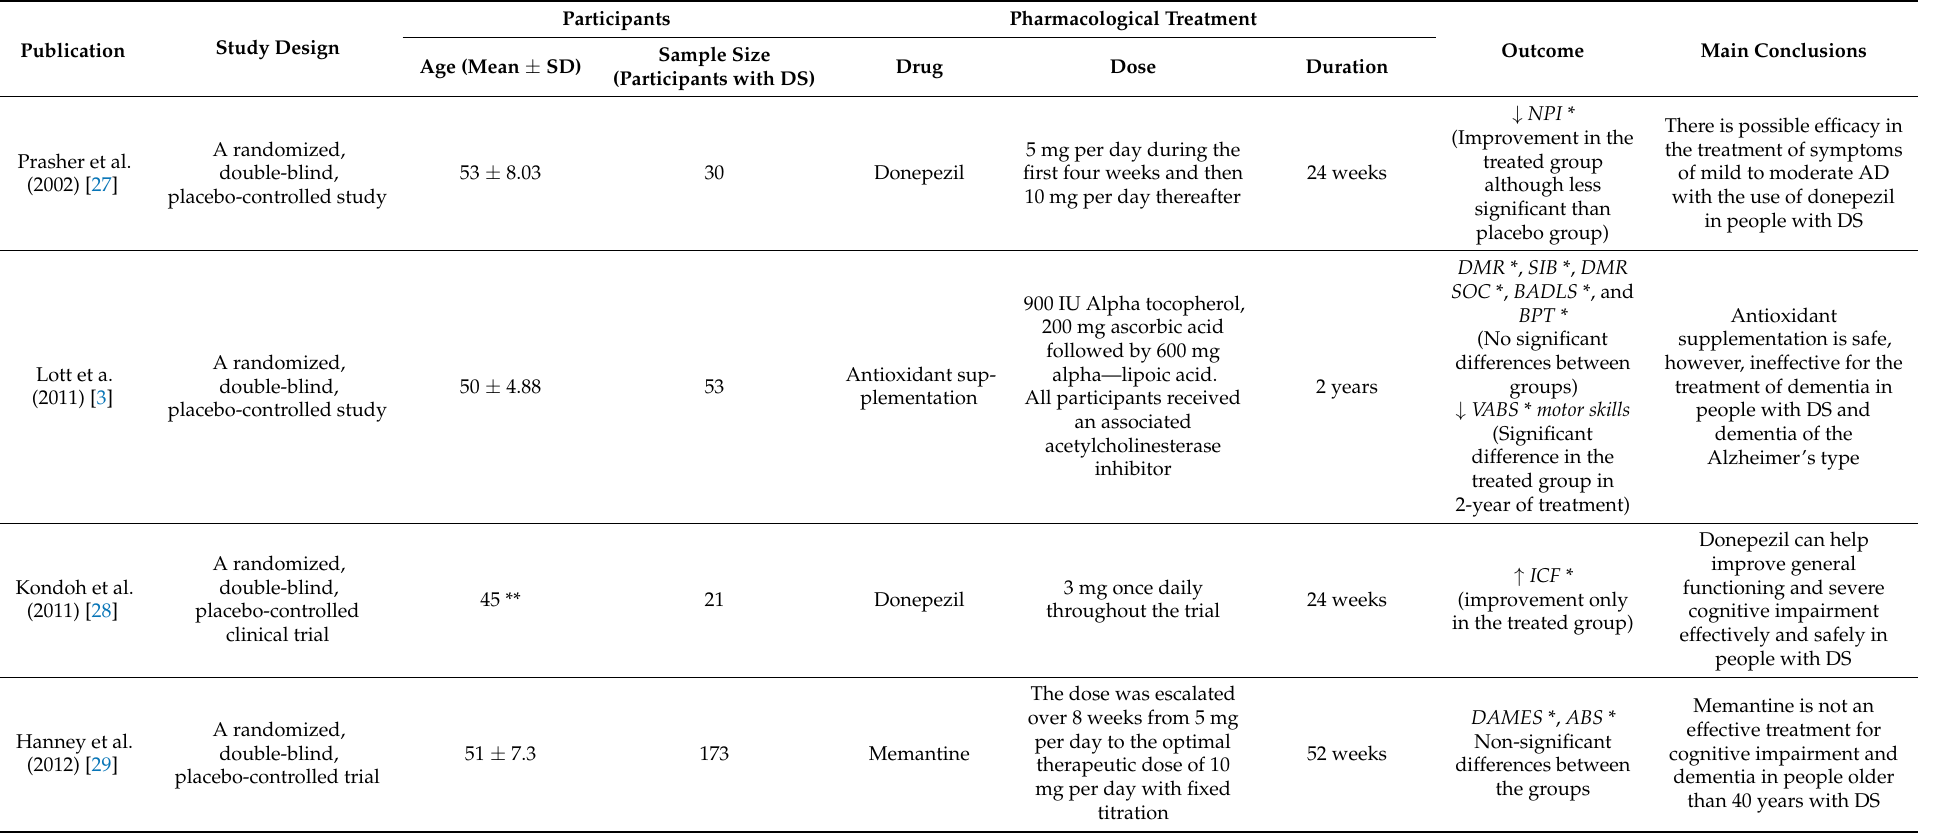
Table 1. Characteristics of the included